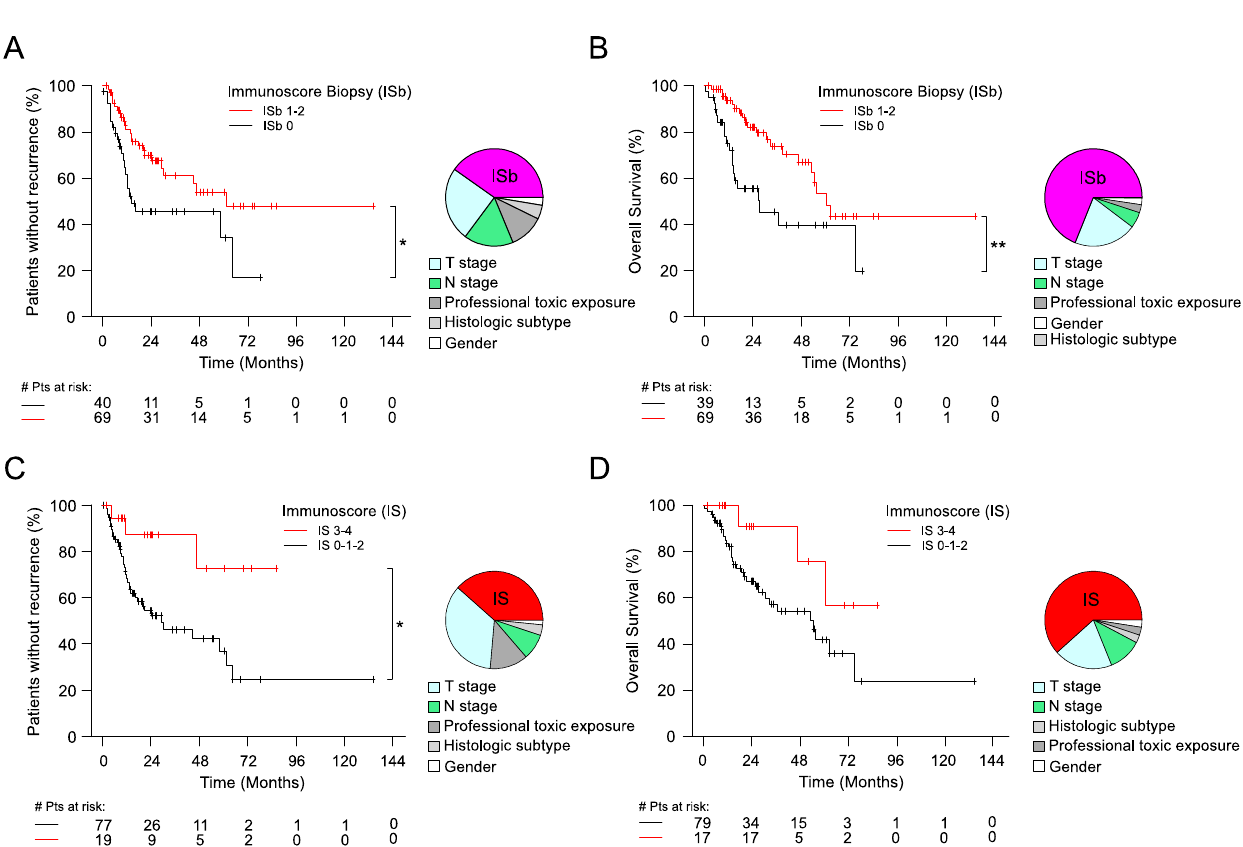
Figure 2. The impact of Immunoscore on patient outcome. Kaplan–Meier curves for the Immunoscores are shown for time to recurrence (TTR) ( A , C ) and overall survival (OS) ( B , D ). The pie chart indicates the contribution of χ 2 proportion of ISb and IS to other variables for influencing the survival in the multivariate analysis. ( A , B ) Two Immunoscore categories for the biopsy Immunoscores: ISb-0 (black) and ISb-1–2 (red). ( C , D ) Two Immunoscore categories for Immunoscore: IS-0–2 (black) and IS 3–4 (red). * p < 0.05, ** p < 0.01.